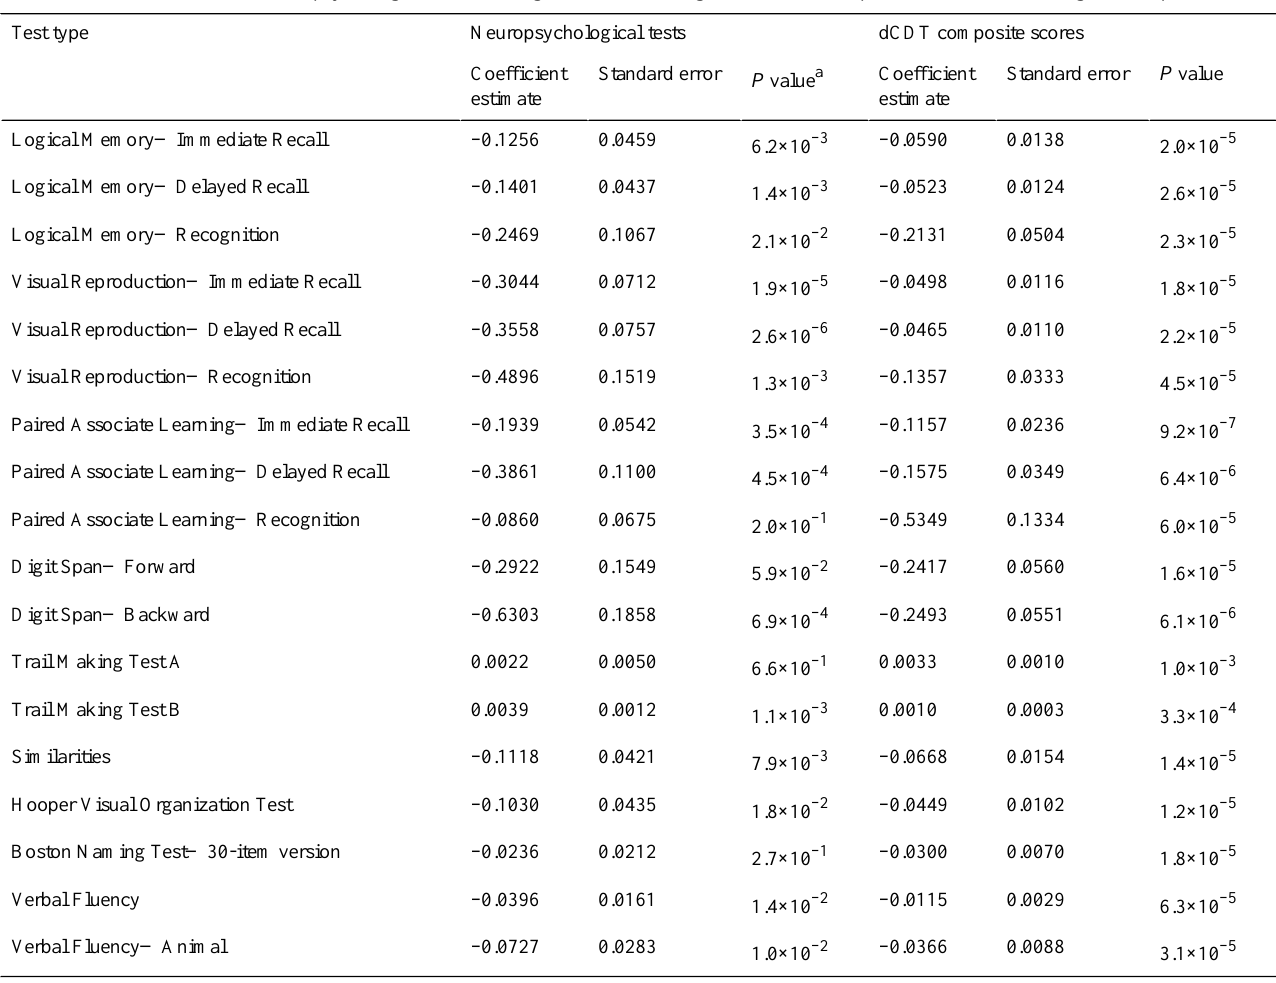
Table 3. Association between neuropsychological tests and digital Clock Drawing Test (dCDT) composite scores and mild cognitive impairment.